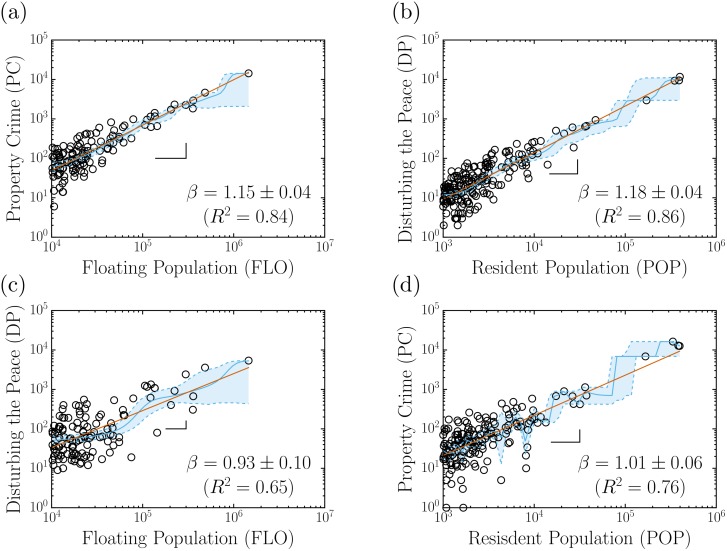
Scattering plots by City Clustering Algorithm (CCA).The red lines represent the simple linear regressions applied to the data, the blue continuous lines represent the Nadaraya-Watson method [46, 47] and the blue dashed lines delimit the 95% confidence interval (CI) estimated by bootstrap. (a) A superlinear relationship was found, with exponent β = 1.15 ± 0.04, between the floating population (FLO) and the property crimes (PC). (b) A superlinear relationship was also found between the resident population (POP) and the disturbing the peace (DP) complaints, with exponent β = 1.18 ± 0.04. (c)-(d) The scattering plots of DP with FLO and PC with POP show an isometric relation was found between the variables, but with lower correlations than (a) and (b). The R2 is defined as determination coefficient [44, 45].